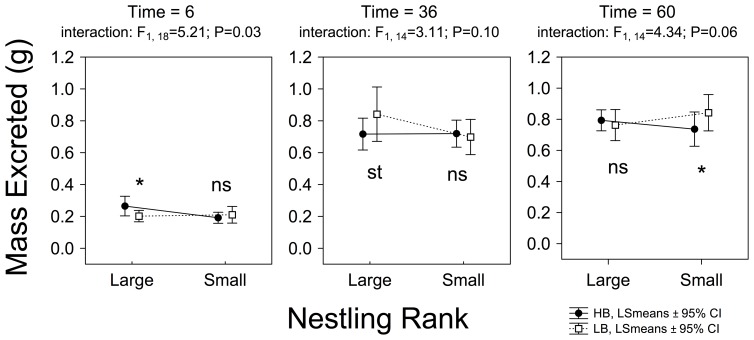
Effects of the experimental treatment on mass excreted by nestlings according to nestling rank calculated from RM-ANOVAs in the experimental sessions where the interaction effects between treatment and nestling rank resulted significant (or almost).The significance values of interactions between experimental treatment and nestling rank are also shown. P-values associated to LSD post hoc (i.e. treatment effect within nestling rank) tests are indicated as ns: P>0.05; st: 0.1≤P≥0.05; *: P<0.05; **: P<0.001 and ***: P<0.0001.